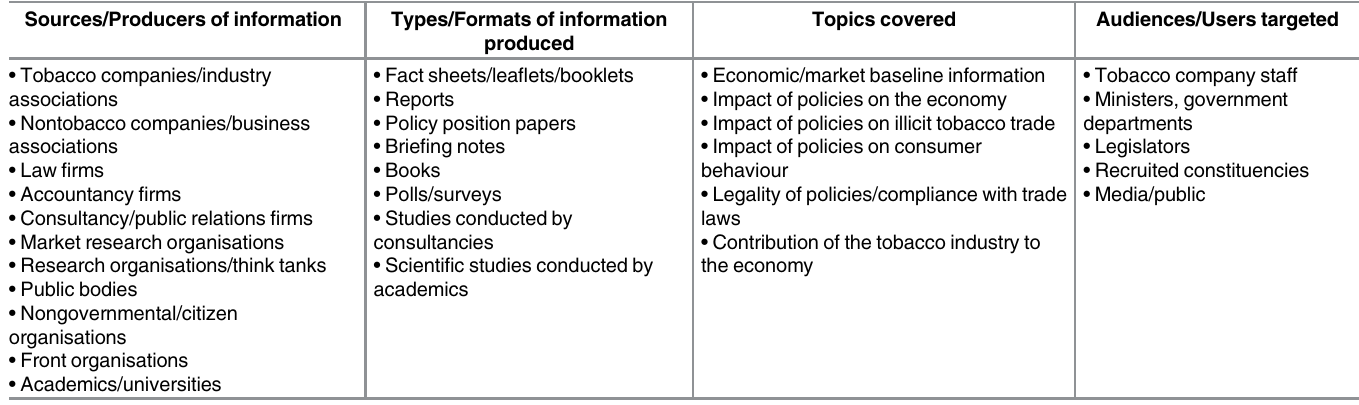
Topics covered Audiences/Users produced